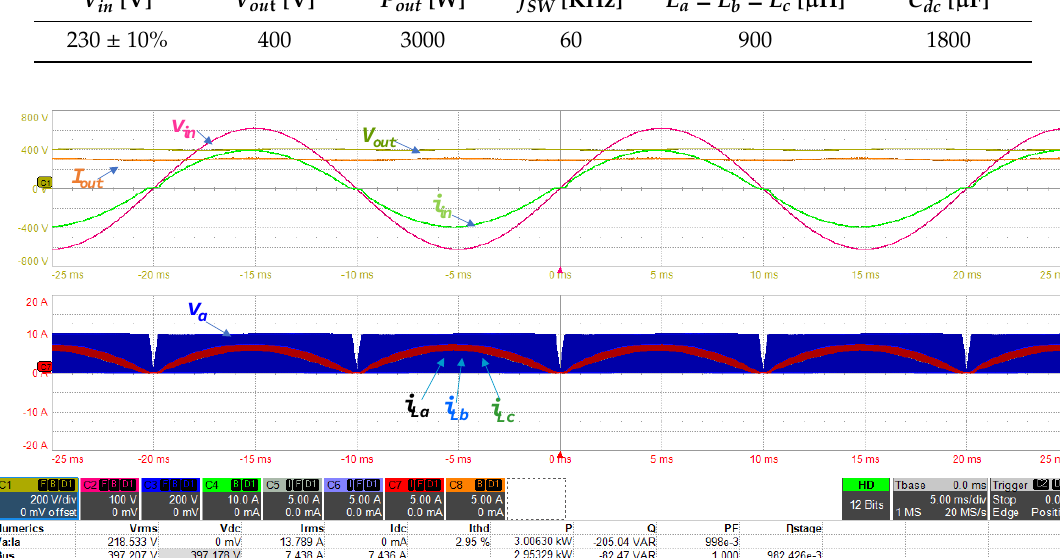
Figure 10. ( a ) Interleaved three cells boost interleaved PFC converter set-up with controller circuit. The PFC circuit is linked to a full-bridge diode rectifier, an electronic load to emulate a current